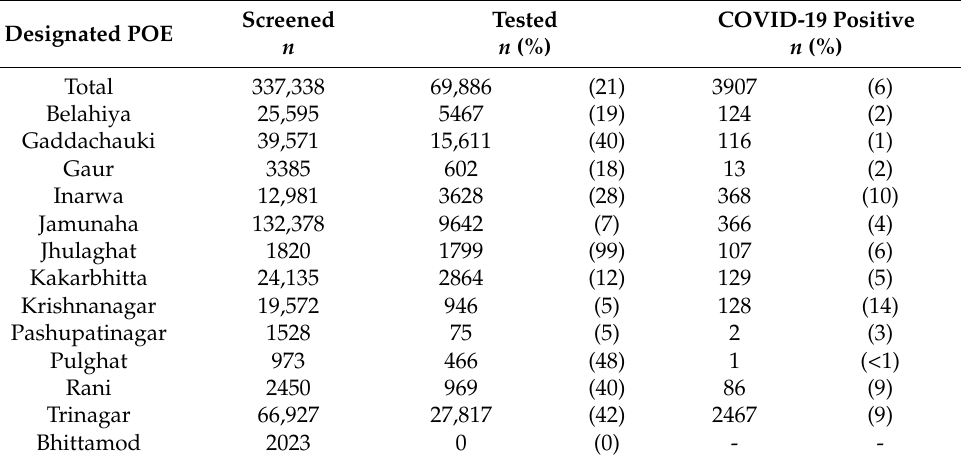
Table 1. Screening, testing and positive COVID-19 diagnoses in travelers at each POE in Nepal: 19